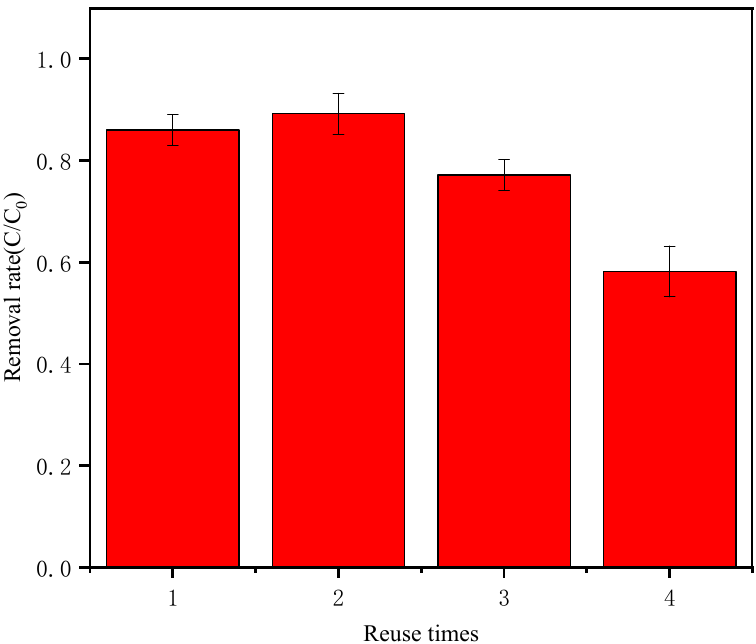
Figure 13. Effect of repeated use of catalyst materials on PNP removal.